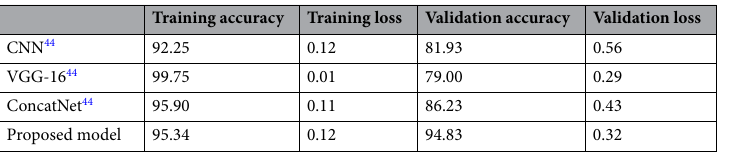
Table 5. Hyperparameter values of various